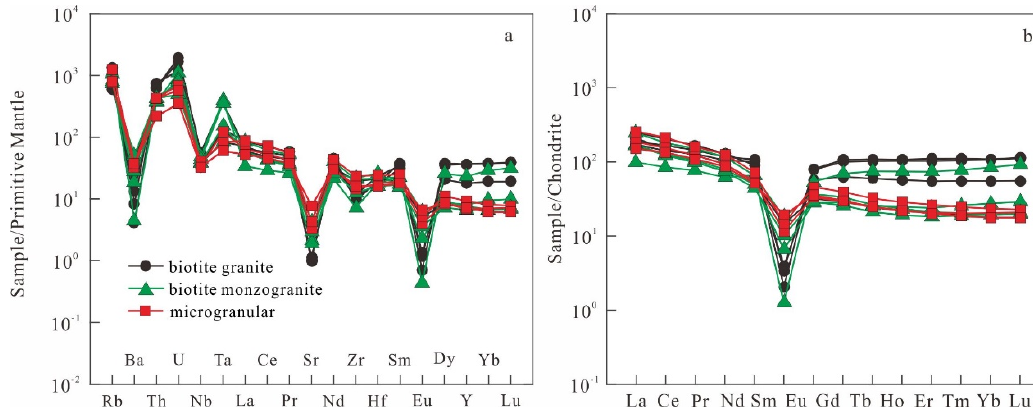
Figure 8 . ( a ) Primitive-normalized trace element spider diagram of the Xitian intrusion; ( b ) Chondrite- normalized REE patterns for the Xitian intrusion. Normalized values are from